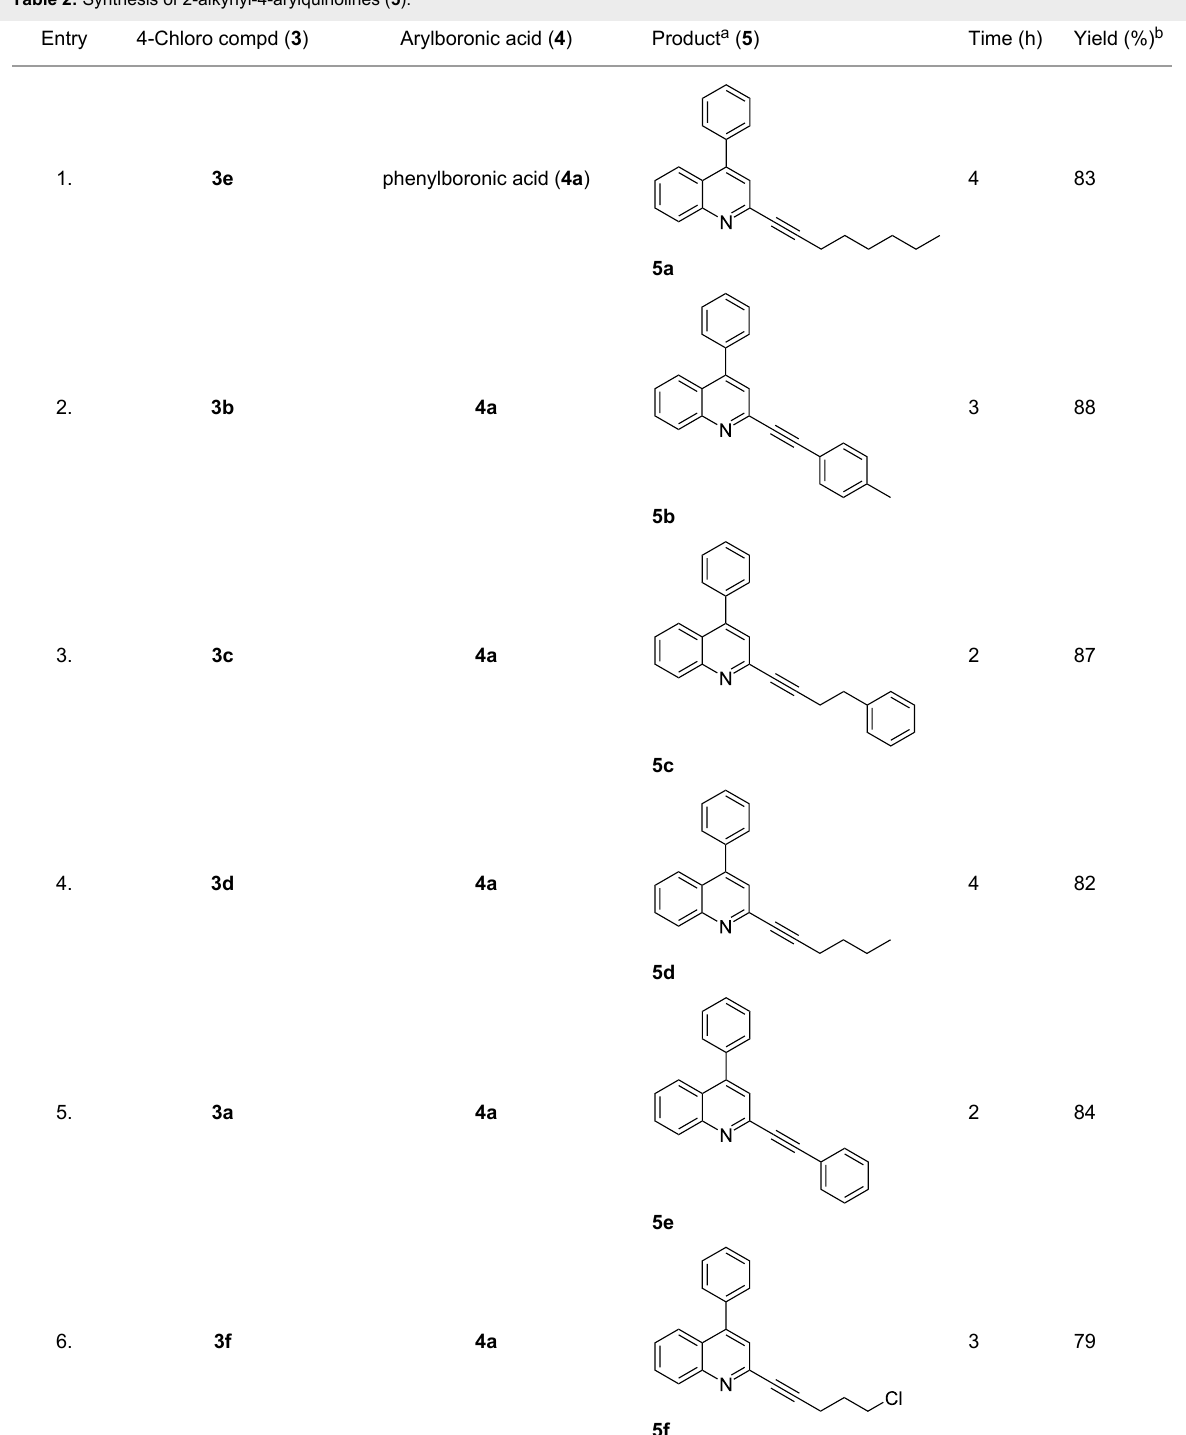
Table 2: Synthesis of 2-alkynyl-4-arylquinolines ( 5